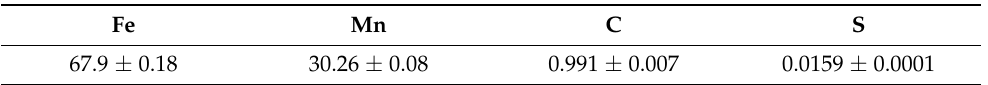
Table 1. Results of chemical composition analysis of the laser powder bed fusion (LPBF) bulk samples of Fe-30Mn-1C-0.02S (FeMnCS) in wt%. Fe Mn C S 67.9 ± 0.18 30.26 ± 0.08 0.991 ± 0.007 0.0159 ± 0.0001